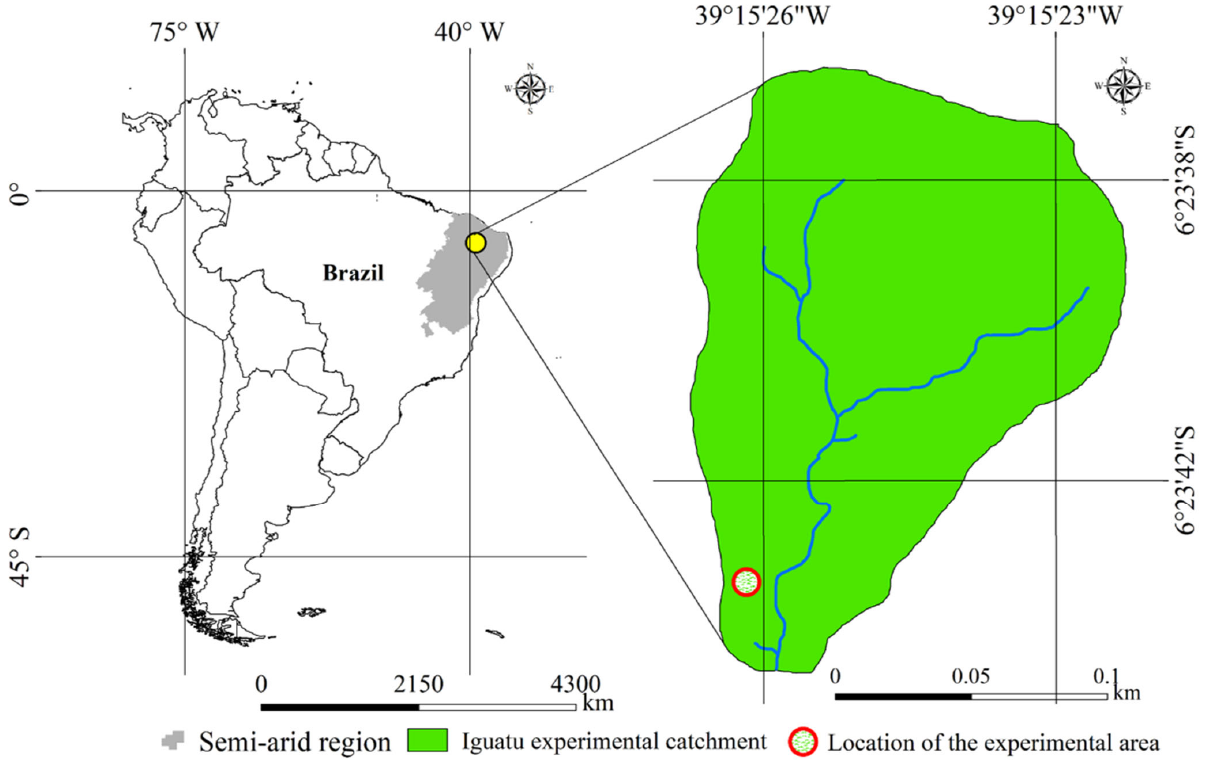
Figure 1. Location of the experimental area in the municipality of Iguatu CE, Northeastern Brazil.